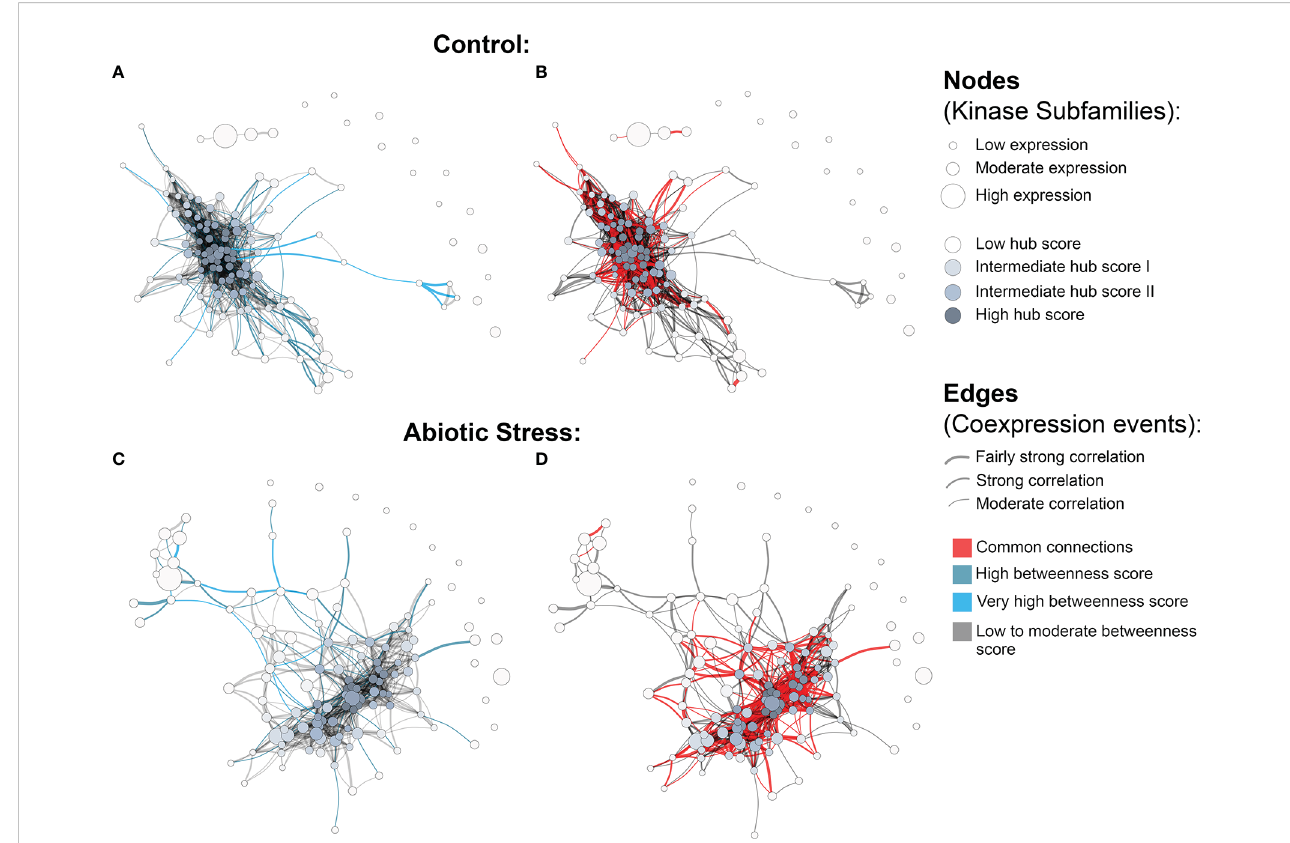
FIGURE 3 Coexpression networks for H brasiliensis (Hbr) kinase subfamilies. (A) Hbr control network with betweenness values highlighted in light blue. (B) Hbr control network indicating edge similarities (red) with the Hbr stress network. (C) Hbr abiotic-stress network with betweenness values highlighted in light blue. (D) Hbr abiotic stress network indicating edge similarities (red) with the Hbr control network. “ 3 Coexpression networks for H brasiliensis (Hbr) kinase